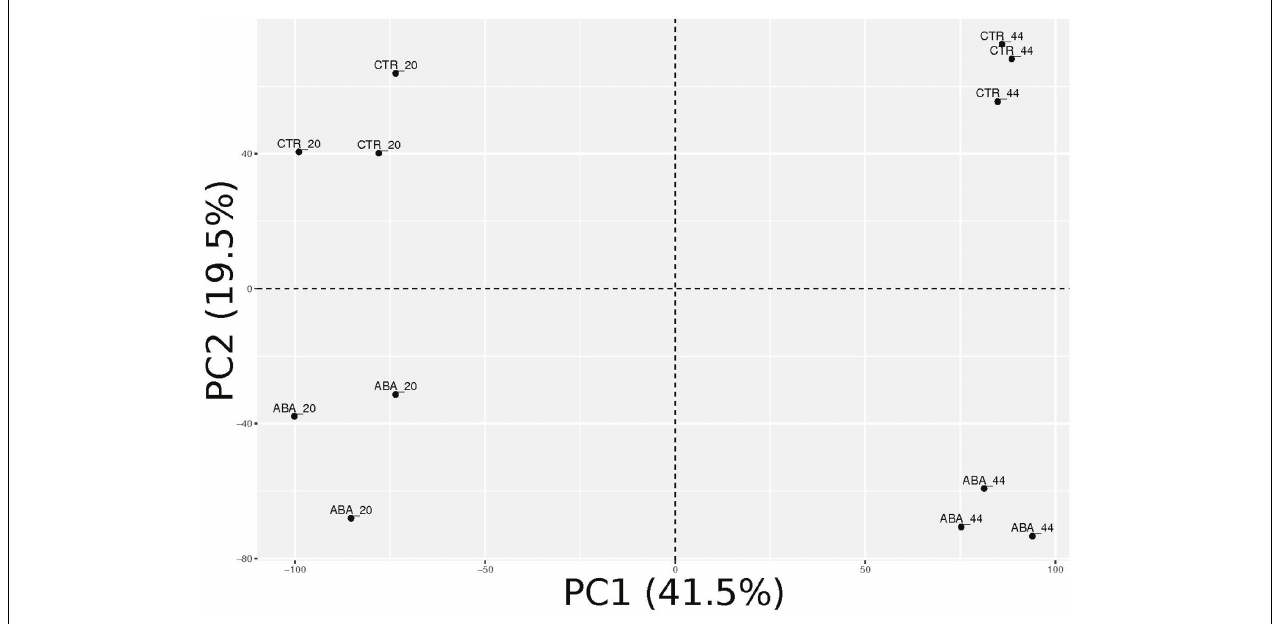
FIGURE 3 | Principal component analysis (PCA) of ABA-treated and control berry skin samples transcriptomes. Biological replicates are grouped and very well separated according to the experimental condition along the first two principal components, which together explain 61% of the overall variance.